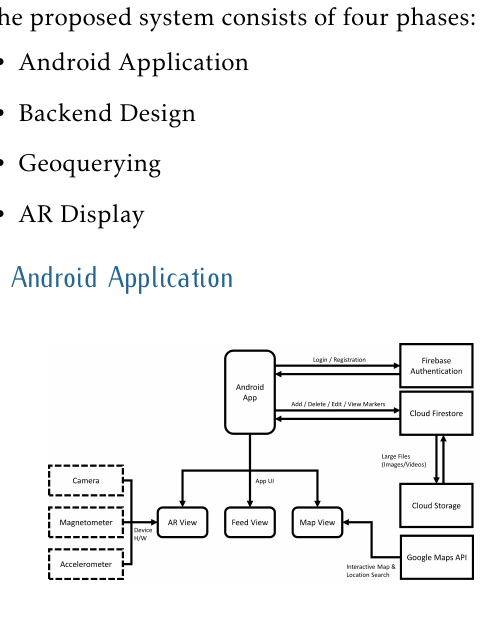
Figure 1. Working of Proposed System